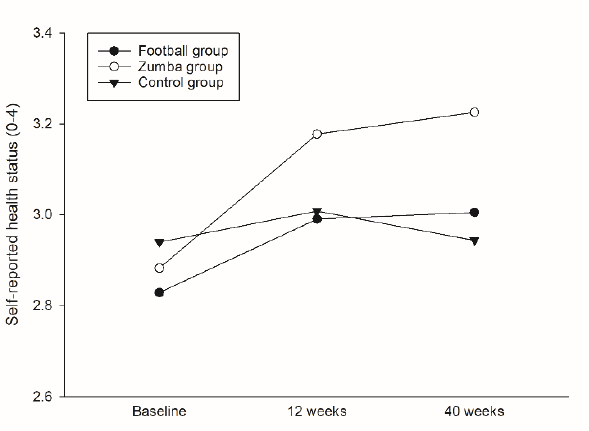
Figure 2. Between-group differences in self-reported health status over 12 and 40 weeks.